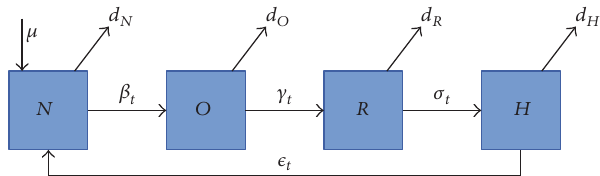
Figure 1: Flow diagram of the mathematical model (3)–(6) for the dynamics of cocaine consumption in Spain. The boxes represent the subpopulations and the arrows represent the transitions between the subpopulations. Arrows are labeled by the parameters of the